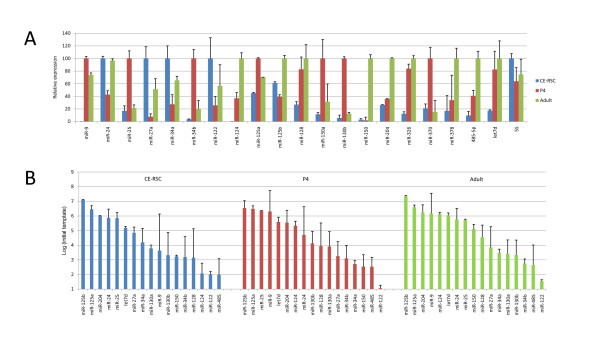
miRNA expression detected by RT-PCR. (A) Relative quantification of selected miRNAs in porcine CE-RSCs and murine P4 and adult retina. (B) Absolute miRNA expression levels estimated from qRT-PCR data.